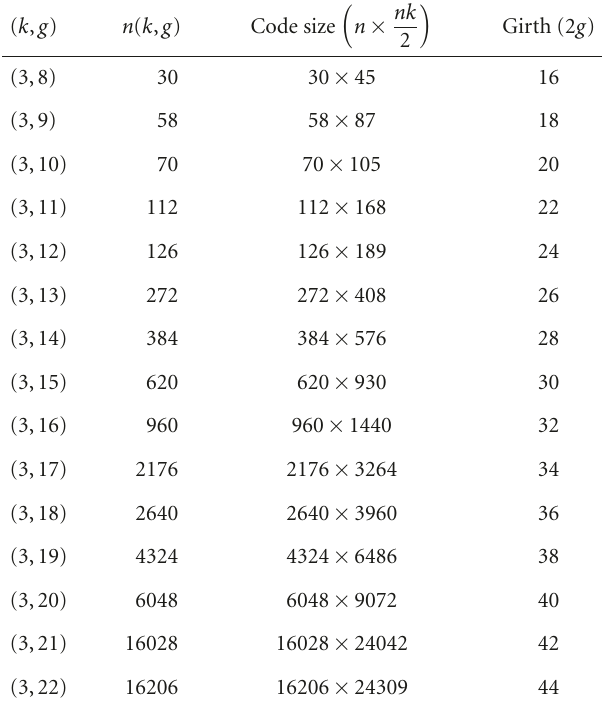
Table 1: Sizes of some known cubic